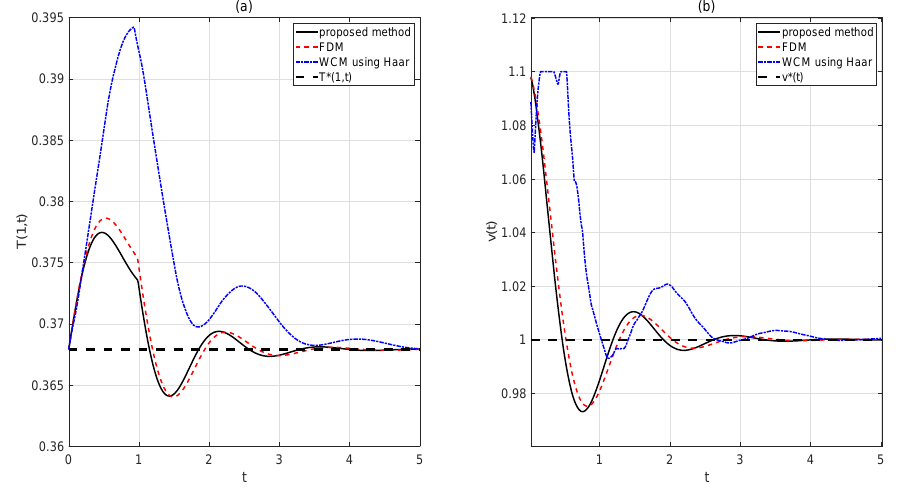
Figure 8. The terminal temperature response T(1,t) ( a ) and the flow velocity v ( t ) ( b ).